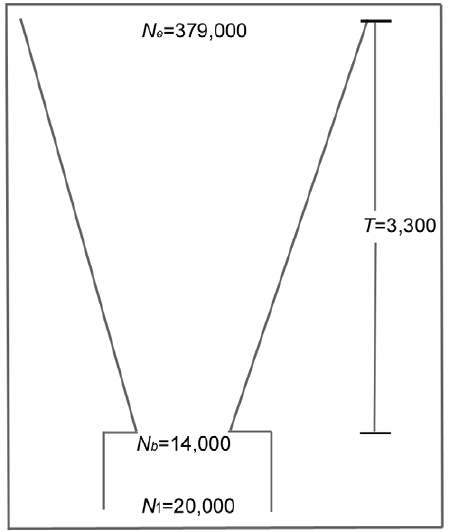
Figure 2. Demographic model. The constant ancestral population ( N 1 ) is followed by a population bottleneck with a reduction of effective size ( N b ), and then by an exponentially expansion with T generations, until to the present population ( N e